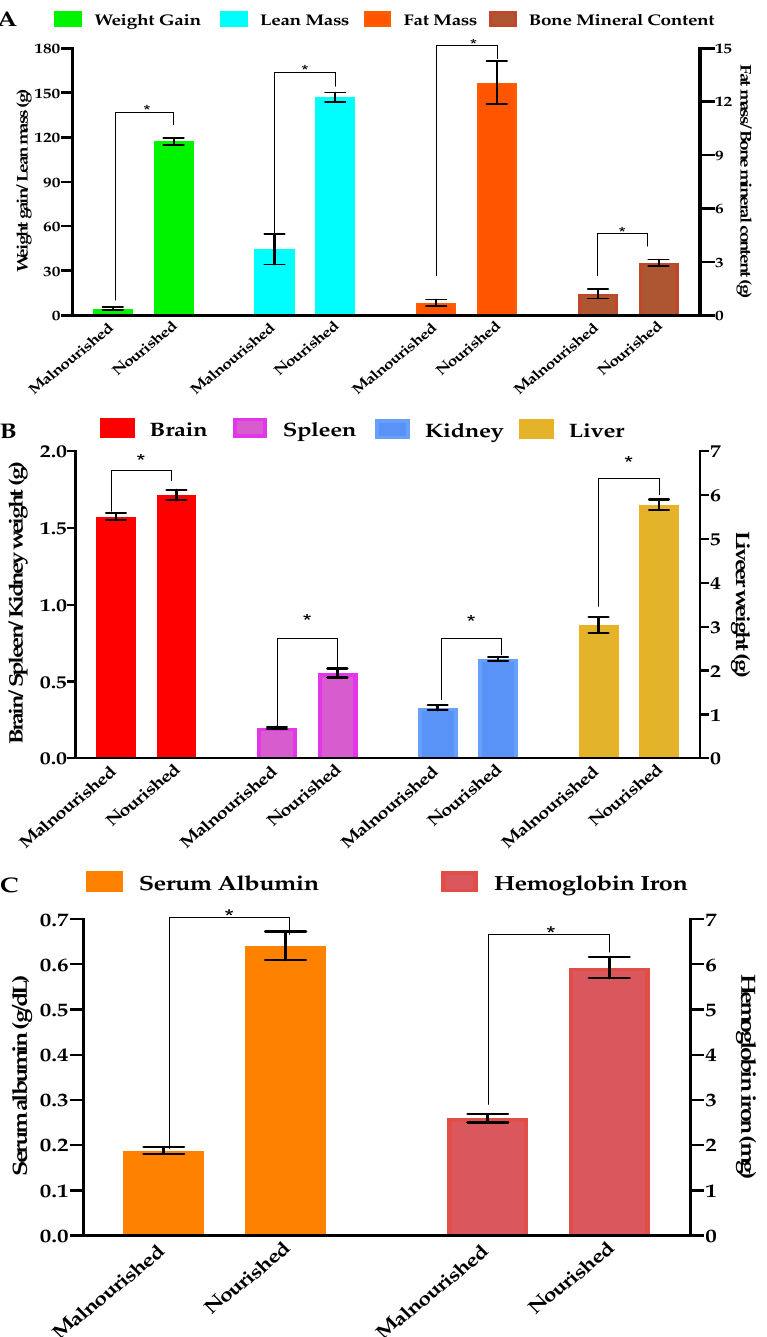
Figure 2. Effects of feeding low protein-Fe and protein-Fe sufficient diets on body composition, organ weights, serum albumin, and hemoglobin iron. ( A ) Weight gain, lean mass, fat mass, bone mineral content, ( B ) Brain, spleen, kidney, liver weights, ( C ) Serum albumin, hemoglobin iron. Data are presented as means ± SEM, n = 5, * Significant at p < 0.008 according to students’ t -test.